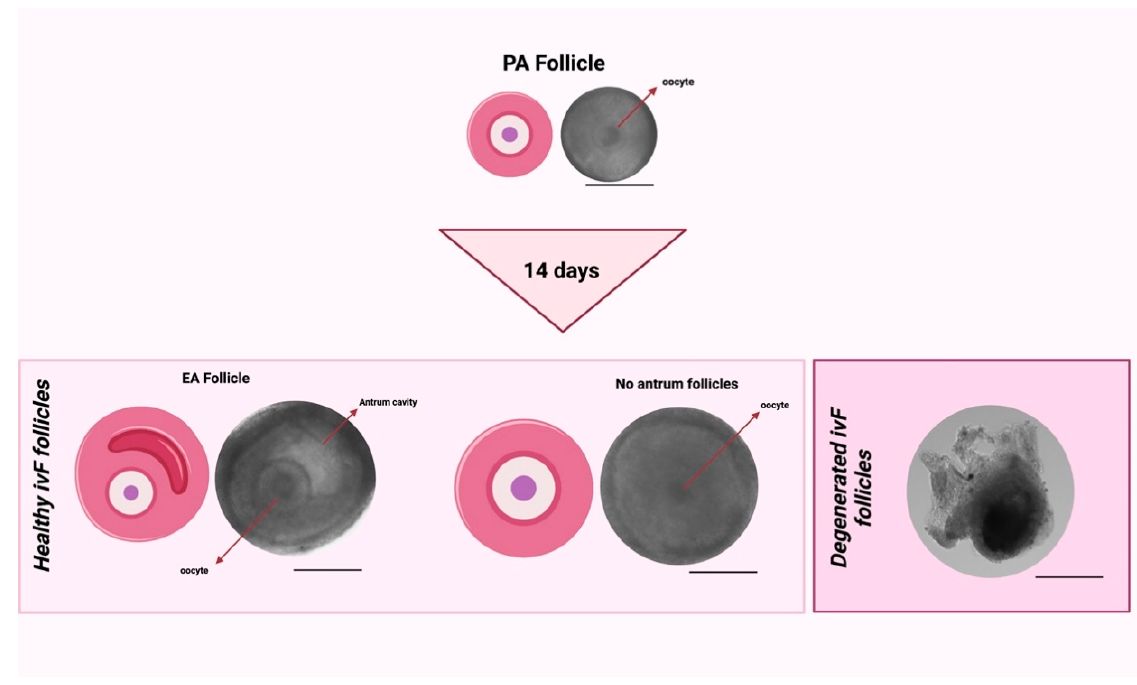
Figure 2. Comparison between healthy follicles after ivF cultures (no antrum and EA follicles) vs. unhealthy follicles after ivF cultures (degenerated follicles). Scale bar: 200 μ m. Created with BioRender.com